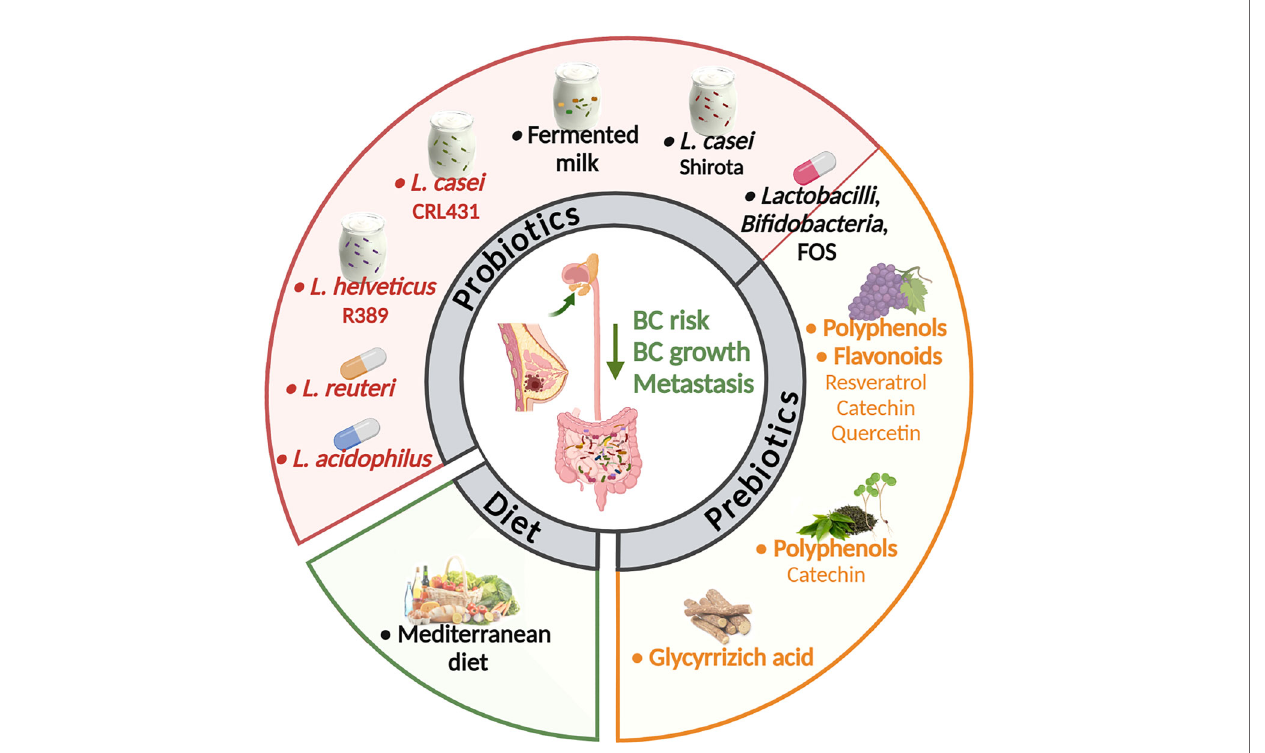
FIGURE 2 | Strategies to modulate the microbiota in BC murine models and patients. Many options to alter the composition of the gut and tumor-associated microbiota are under investigation as a clinical strategy in cancer treatment and prevention. In BCs the anti-tumor activity of probiotics, prebiotics and diet was explored mainly in preclinical models. Only few studies (in black) found an association between the use of probiotics, as soy milk fermented with Lactobacillus casei Shirota (109) or fermented milk (110), and of a Mediterranean diet (111) with a reduced risk to develop BC in women. In another study the oral administration of different Lactobacilli and Bi fi dobacteria in combination with fructooligosaccharide (FOS) modi fi ed circulating risk factors, potentially reducing BC risk (112). In preclinical models, oral administration of Lactobacillus acidophilus or Lactobacillus reuteri live bacteria (113, 114) or fermented milk containing Lactobacillus helveticus or Lactobacillus casei (115, 116) inhibited mammary carcinogenesis or 4T1 BC growth. Lactobacillus casei also had anti-metastastic effects and diminished the capecitabine side effects (117). Also, the use of non-digestible food ingredient that promotes the growth of bene fi cial microorganisms in the intestines (prebiotics) was tested in preclinical models of BC. In details, oral delivery of polyphenols derived from grapes (118) or from green tea in association with broccoli sprouts (119), or the fl avonoid quercetin (120), reduced primary BC growth and metastasis. Also, the glycyrrhizic acid, a phytochemical derived from licorice roots, ameliorated high fat diet-induced metastases of 4T1 BC through the modulation of gut microbiota composition (121) (created by